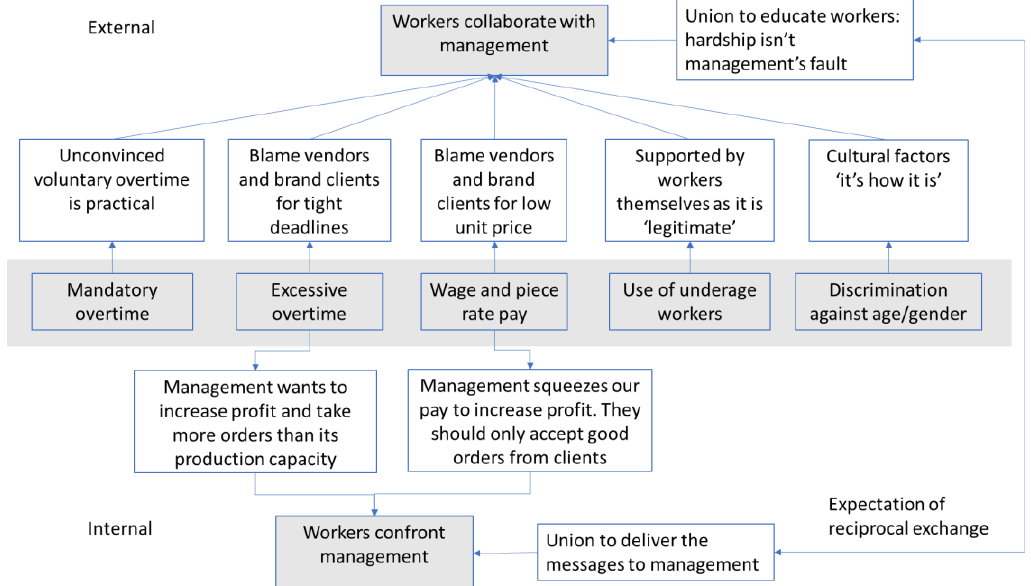
Figure 4. Reciprocal exchange in VCo employment relation.